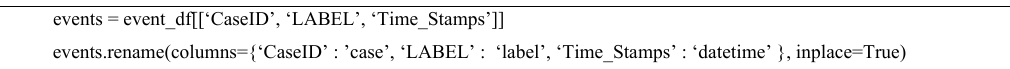
Algorithm 1. Data Selection